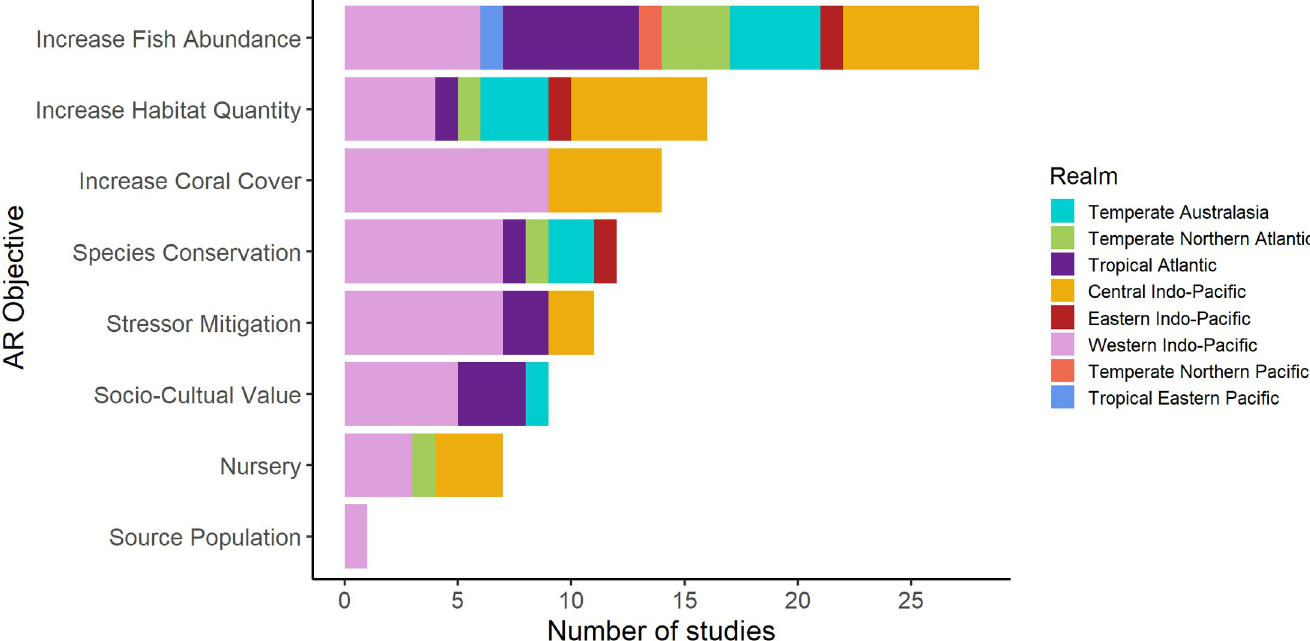
Fig 3. Number of studies that measured each objective by marine realm (Temperate Australasia, n = 11 studies; Temperate Northern Atlantic, n = 6; Tropical Atlantic, n = 12; Central Indo-Pacific, n = 22; Eastern Indo-Pacific, n = 3; Western Indo-Pacific, n = 42; Temperate Northern Pacific, n = 1; Tropical Eastern Pacific, n = 1) in ARs reporting success in meeting conservation objectives. See Fig 2 for map of bioregions.